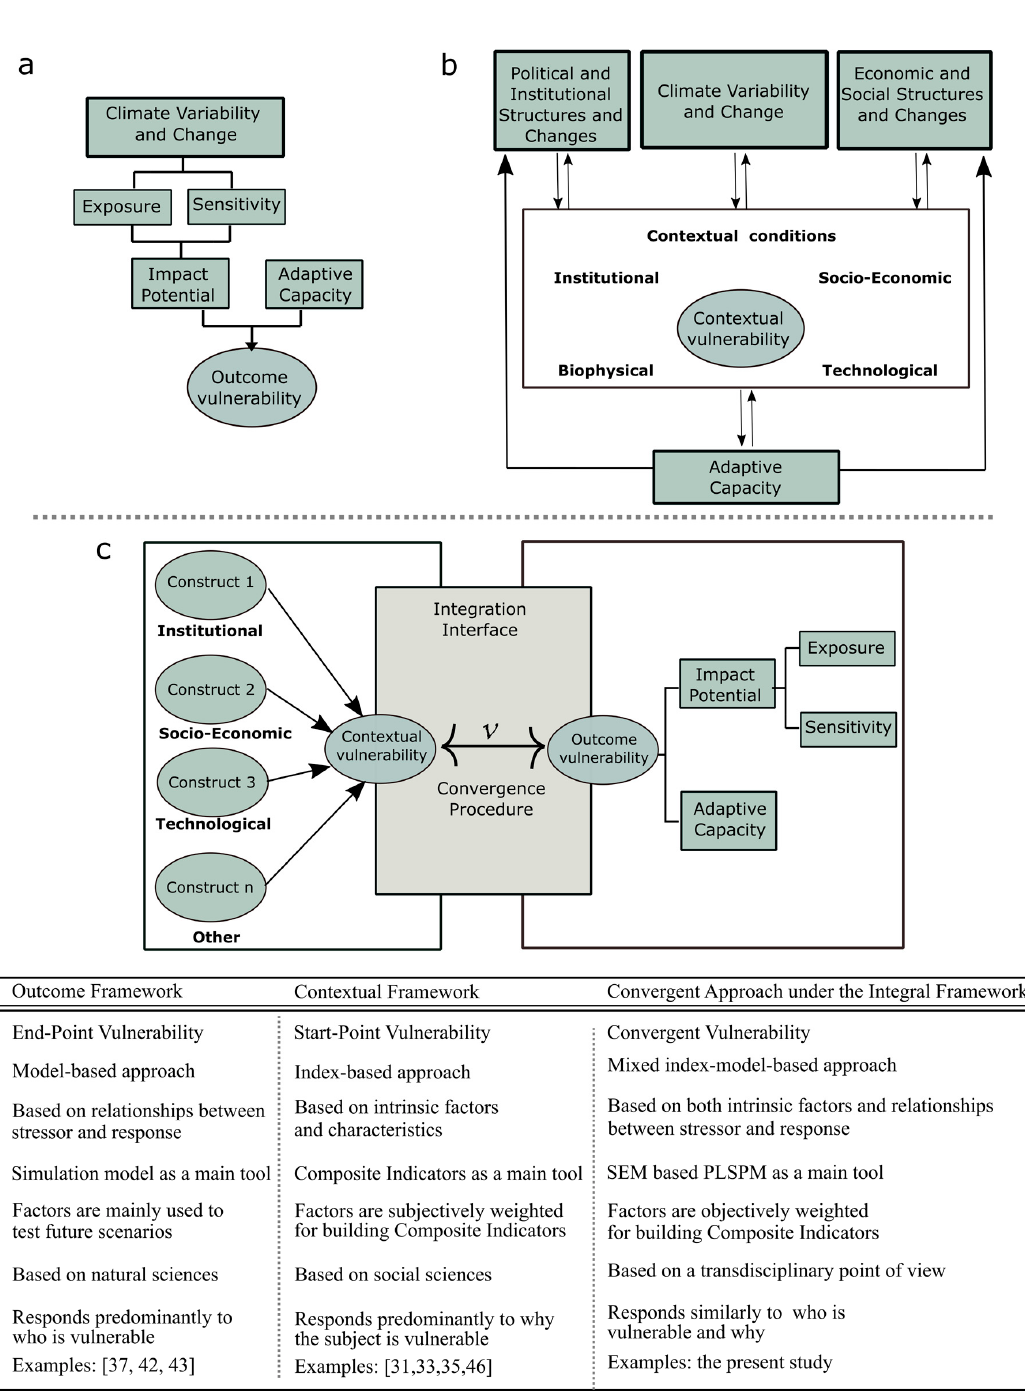
Figure 1. Conceptual scheme of the outcome ( a ) and contextual ( b ) frameworks and the convergent approach under the integral framework ( c ) for vulnerability assessment. Outcome and contextual schemes adapted from Fellman [19]. The main characteristics of each framework are also presented. SEM: Structural Equation Modeling; PLSPM: Partial Least Squares Path Modeling.